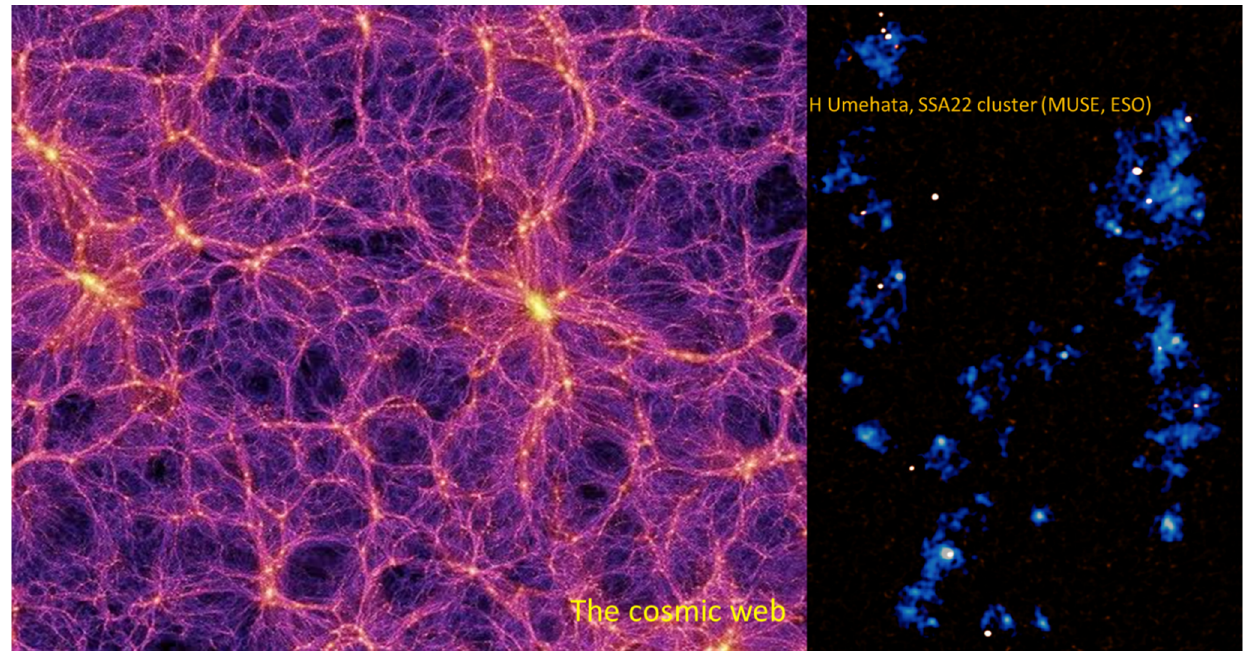
Figure 6. A comparison of the cosmic web as generated by computer simulations with a real observation by H. Humehata of the SSA22 cluster (MUSE, ESO).